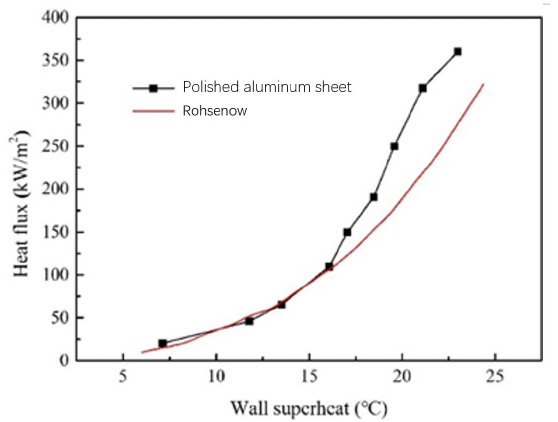
Figure 7. Acetone pool boiling test curves on the surface of an aluminum plate.